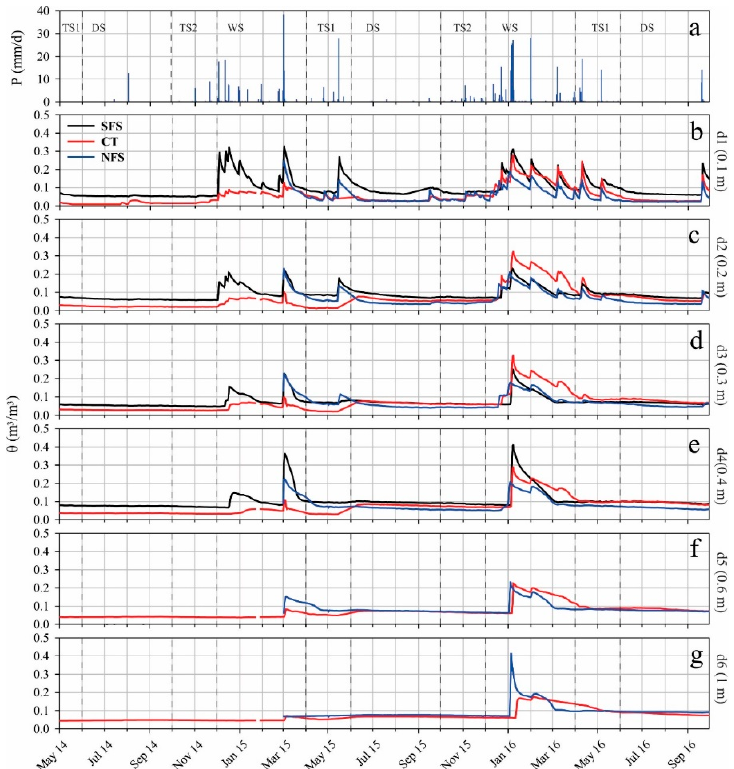
Figure 5. ( a ) Daily precipitation. ( b – g ) Daily-averaged soil water content at depths of 0.1 m, 0.2 m,